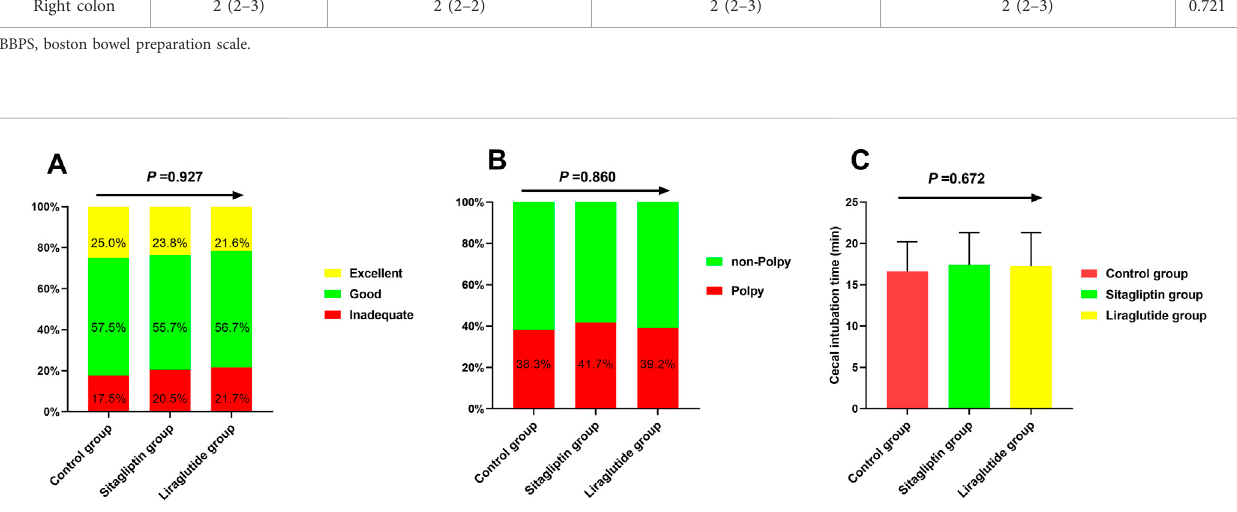
BBPS, boston bowel preparation scale.